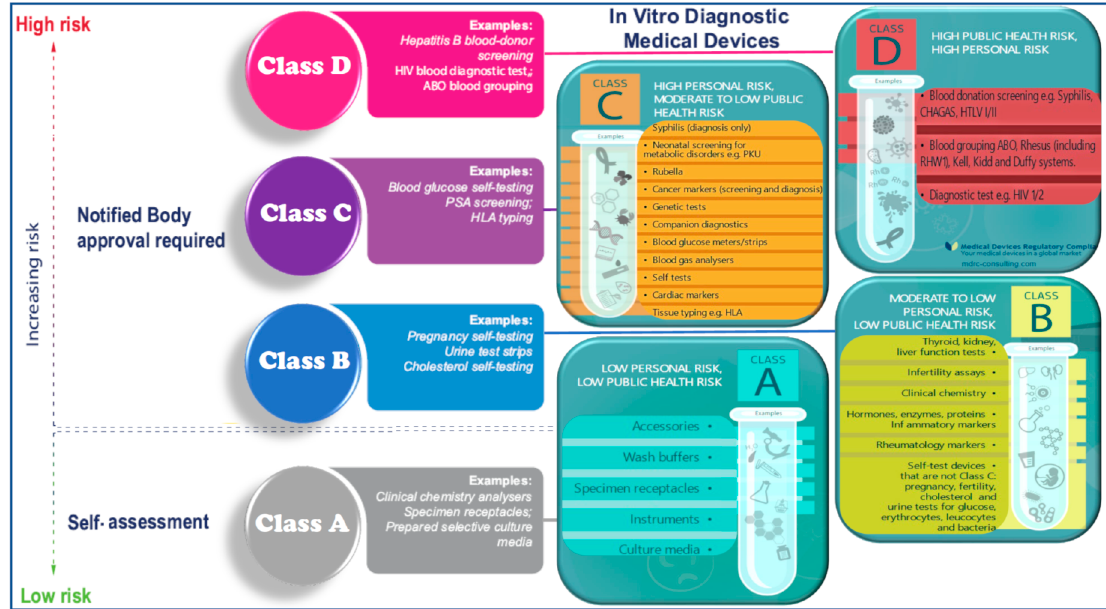
Figure 16. Scheme of the general classification of in vitro diagnostic medical devices depending on the application risk.